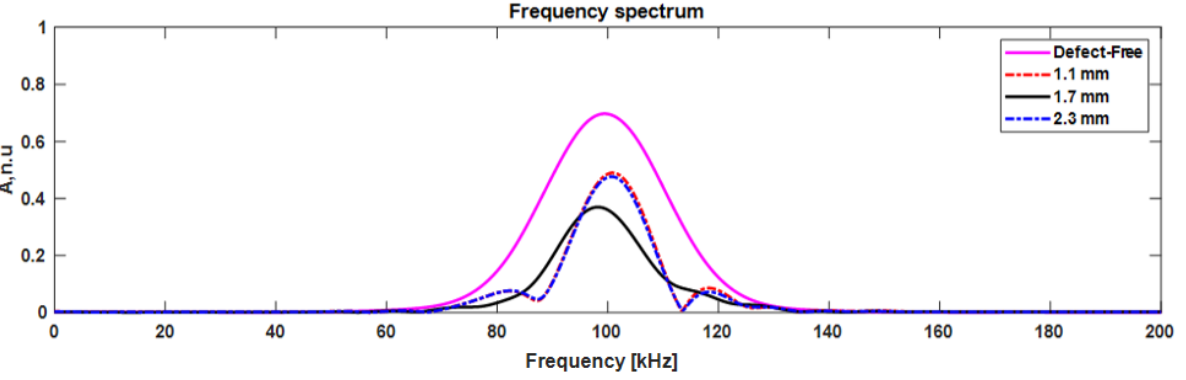
Figure 14. The frequency spectrum of reflected A 0 mode.